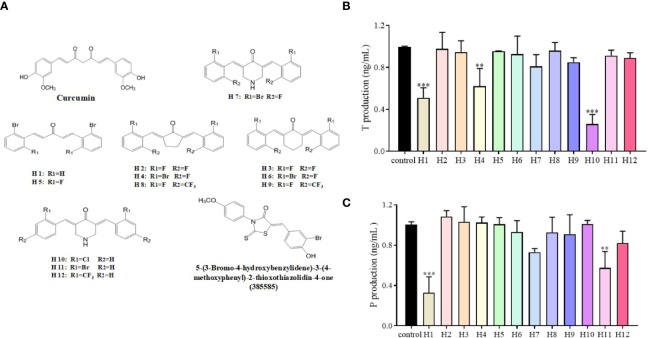
Effects of compounds H1-H12 on LC540 cells transfected with 17β-HSD3. (A) The chemical structures of curcumin and its derivatives, as well as of 5-(3-bromo-4-hydroxybenzylidene)-3-(4-methoxyphenyl)-2-thioxothiazolidin-4-one (385585). Assays for (B) T and (C) P for assessing the effects of H1-H12 on LC540 cells transfected with 17β-HSD3. The results represent the mean ± standard deviation (sd, n = 3); **P < 0.01, and ***P < 0.001 are considered significant vs. the control.